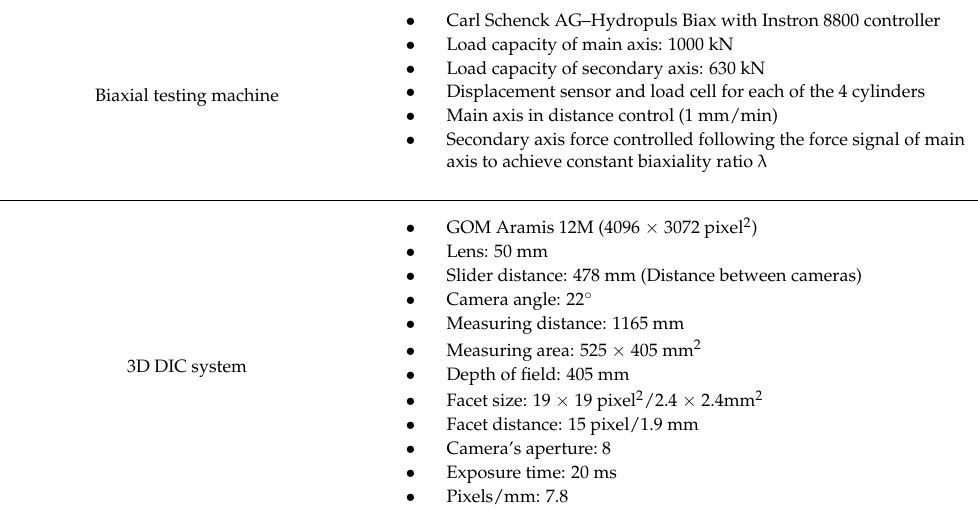
Figure 4. Biaxial testing machine. The insert in the lower left corner shows a cruciform specimen mounted for testing. Table 1. Experimental setup; DIC, digital image correlation system.